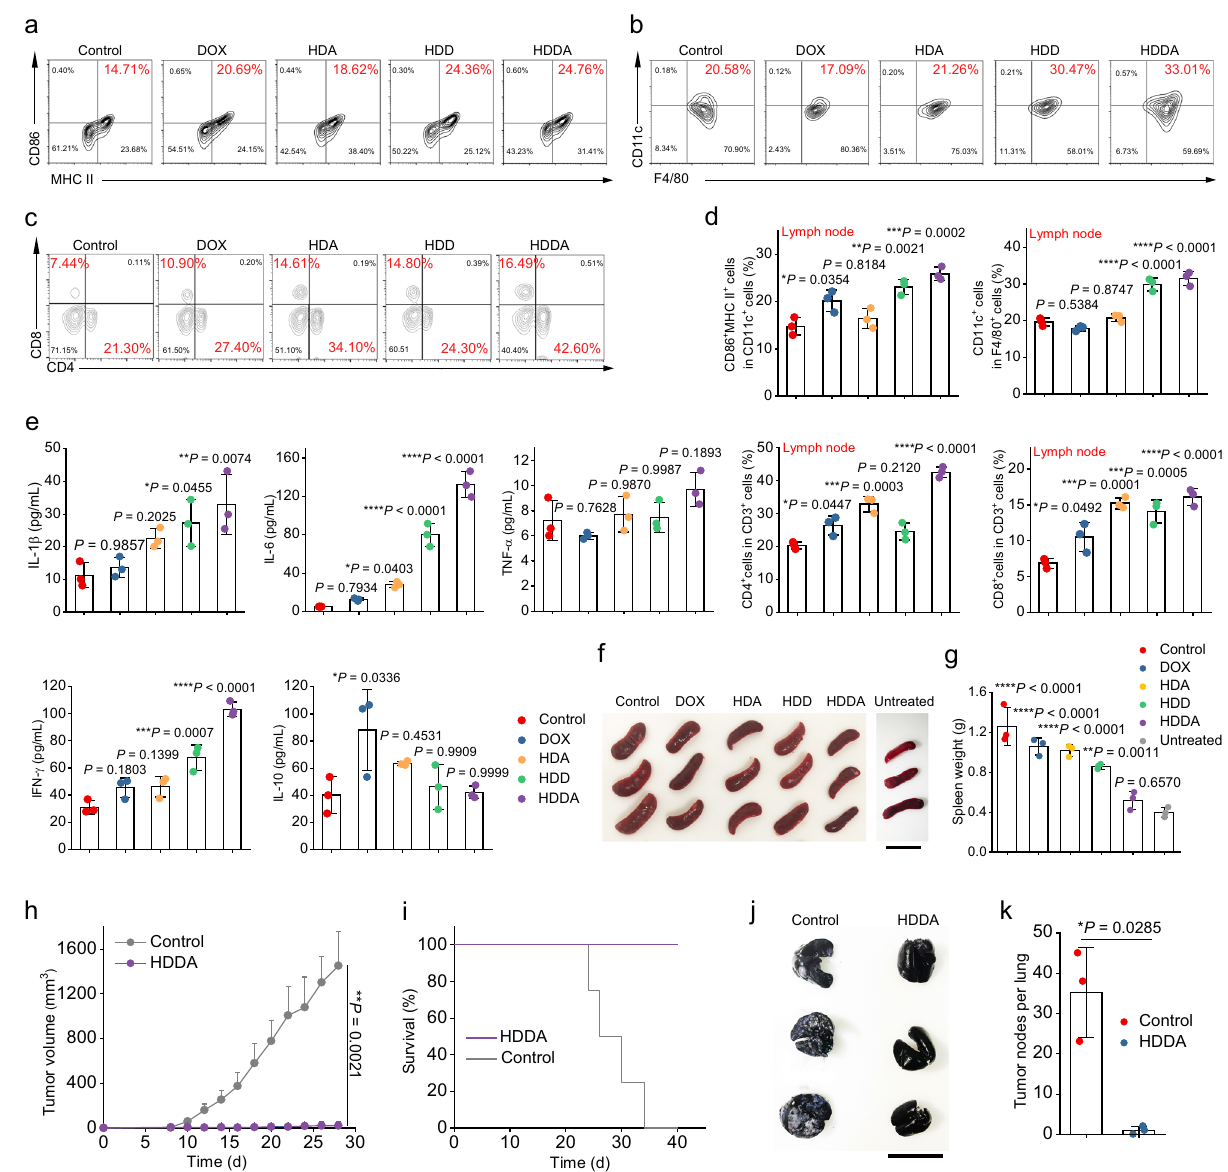
Fig. 7 | HDDA NBs trigger systemic immune responses and durable immuno- logical memory in 4T1 tumor-bearing BALB/c mice. a – d Representative fl ow cytometricplots( a – c )andrelativequanti fi cationresults( d )ofmaturedDCs(CD11c + CD86 + MHC II + ), M1-like macrophages (F4/80 + CD11c + ), helper T cells (CD3 + CD4 +